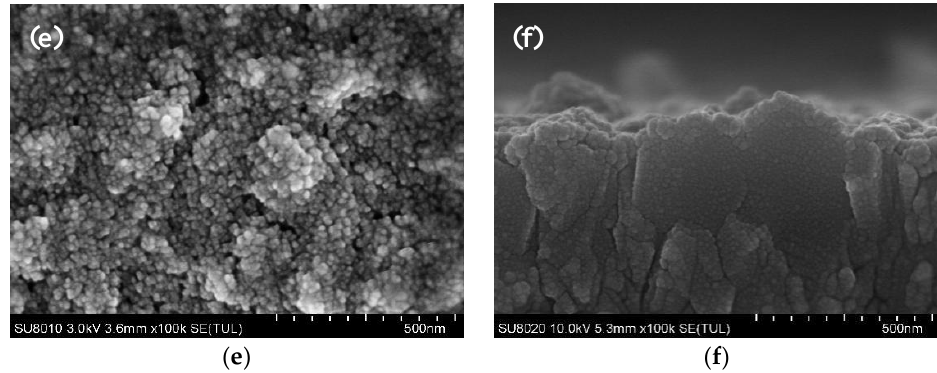
Figure 2. Scanning electron microscope (SEM) images of nano TiO 2 films using Process 1: ( a,c,e ) The top-view images under Direct method, Proportional method, and Delayed method, respectively; ( b,d,f ) The corresponding cross-sectional images. The meaning of Process 1, Direct method, Proportional method and Delayed method is described in the second paragraph of experimental Section 2.2.2.